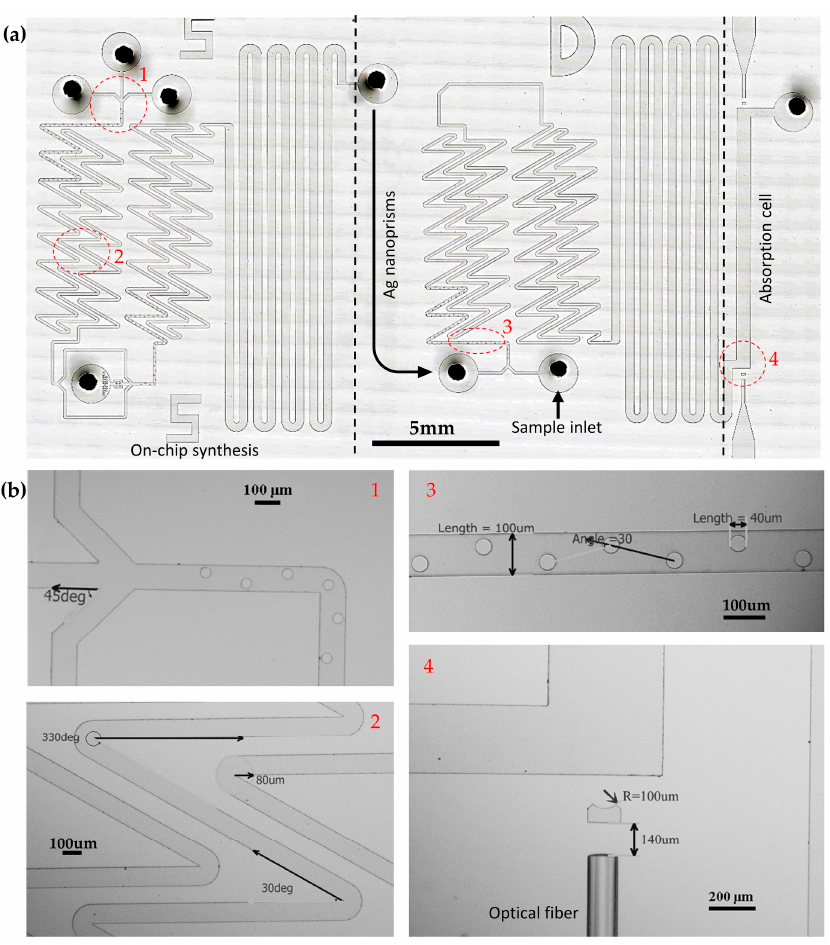
Figure A3. ( a )Large Image of the fabricated chip obtained by image stitching technology and microscopes of the channel design at the positions of inlets ( b1 ), zigzag-channel ( b2 ), microcylinders ( b3 ) and absorption cell ( b4 ).